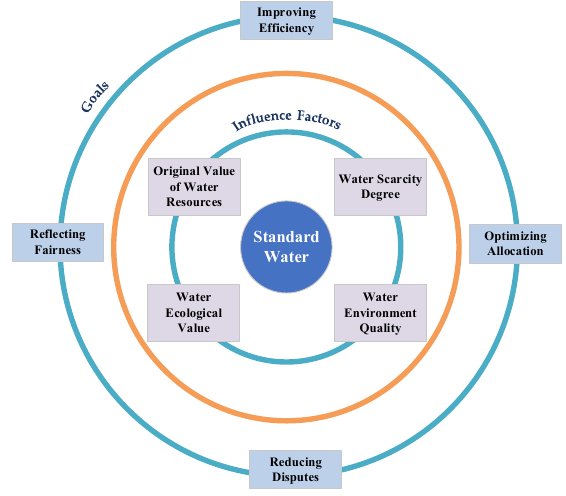
Figure 1. The influence mechanism of SW.